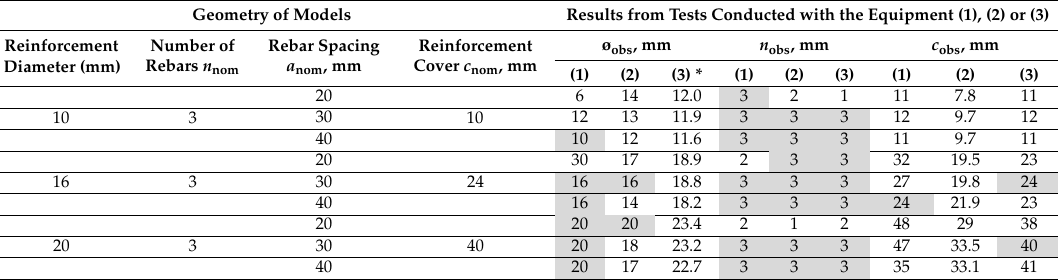
Table 4. Test results for lightweight concrete specimens (at variable